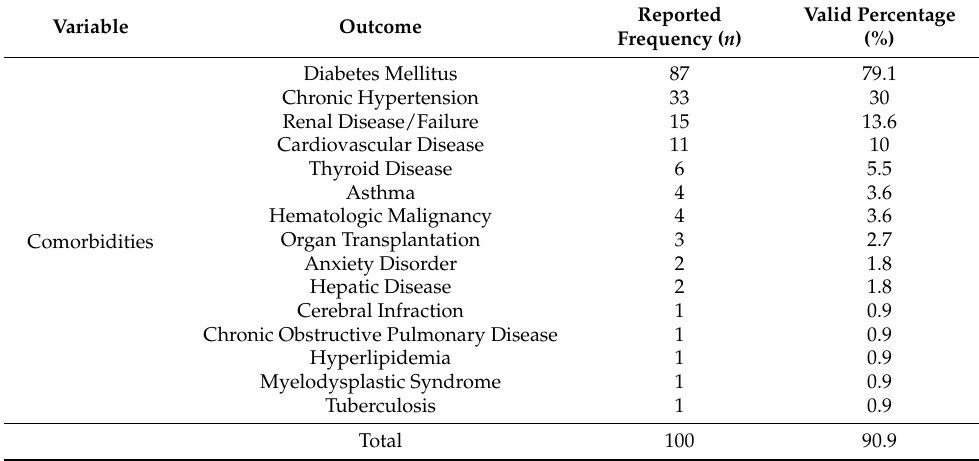
Table 3. Anamnestic Characteristics of COVID-19-associated Mucormycosis (CAM) Cases,